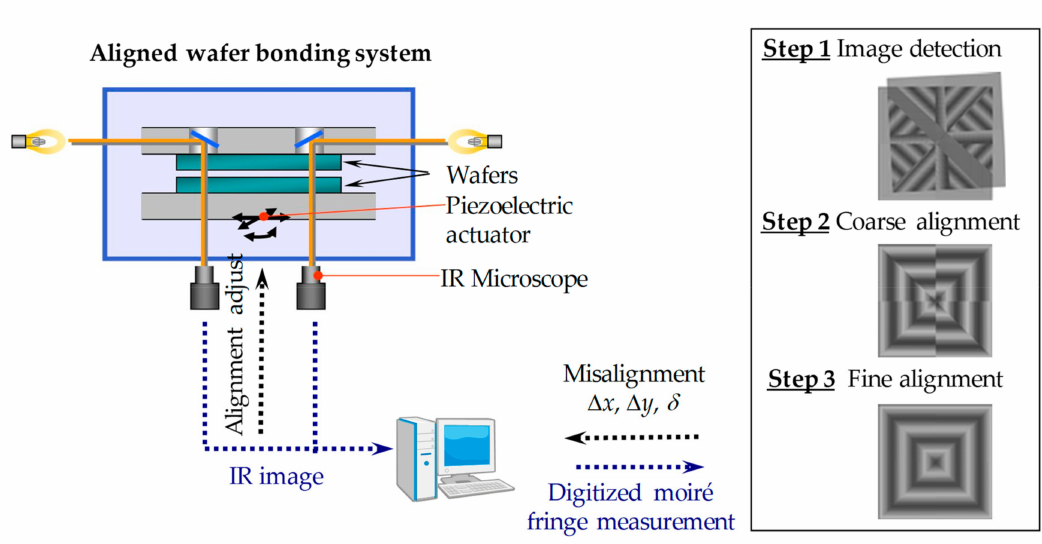
Figure 6. Schematic illustration of the aligned wafer bonding system and the moir é -based alignment process using centrosymmetric grating